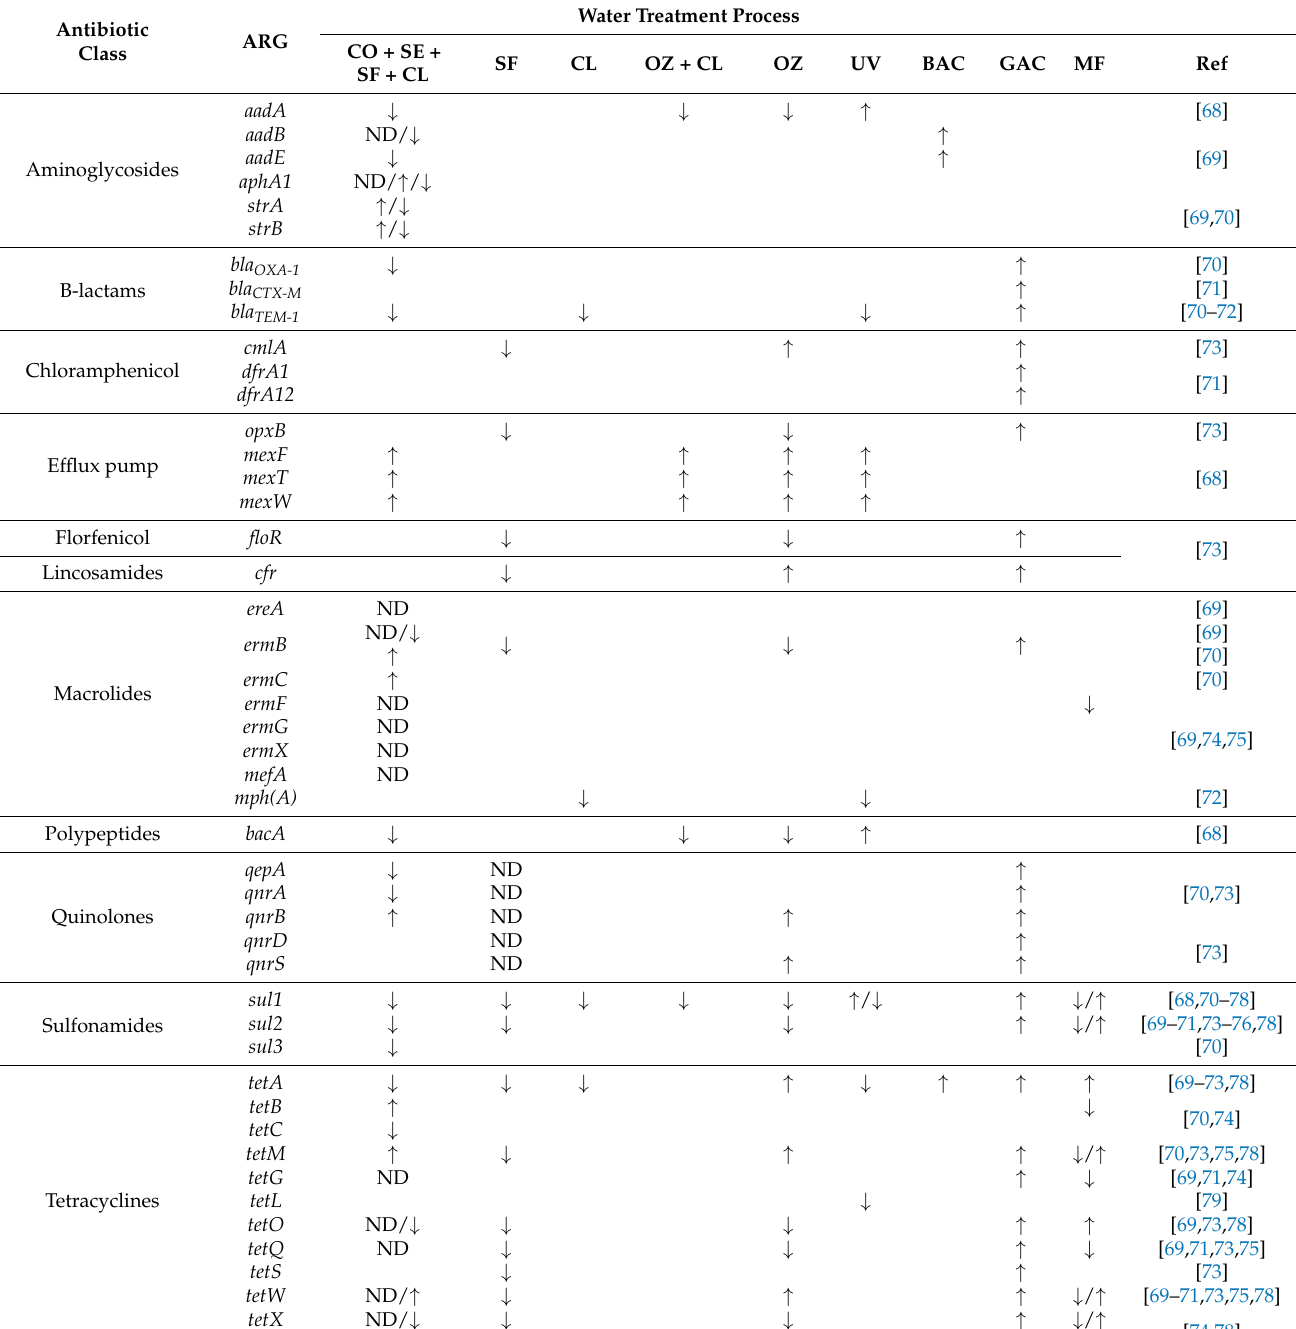
Table 1. ARGs removal efficiency by current water